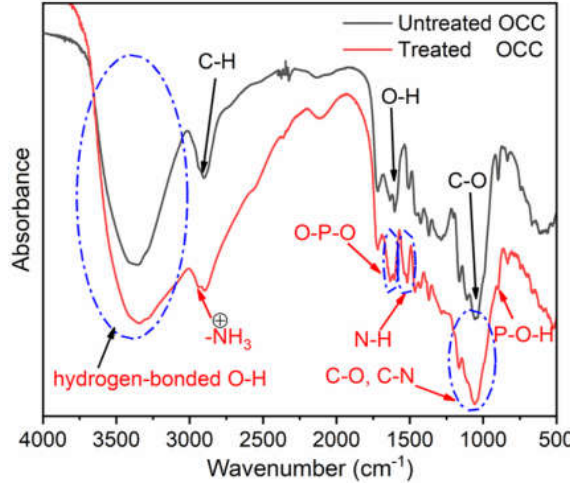
Figure 3. Infrared spectra of FTIR for untreated and treated OCC.